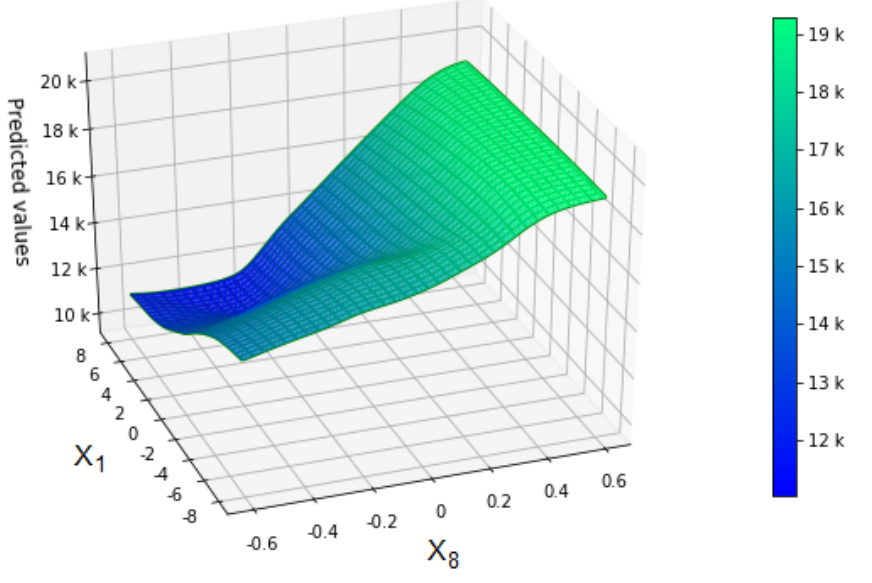
Figure A5. Two-dimensional curve of the ensemble of 10 best performing neural networks with respect to X 1 and X 8 .